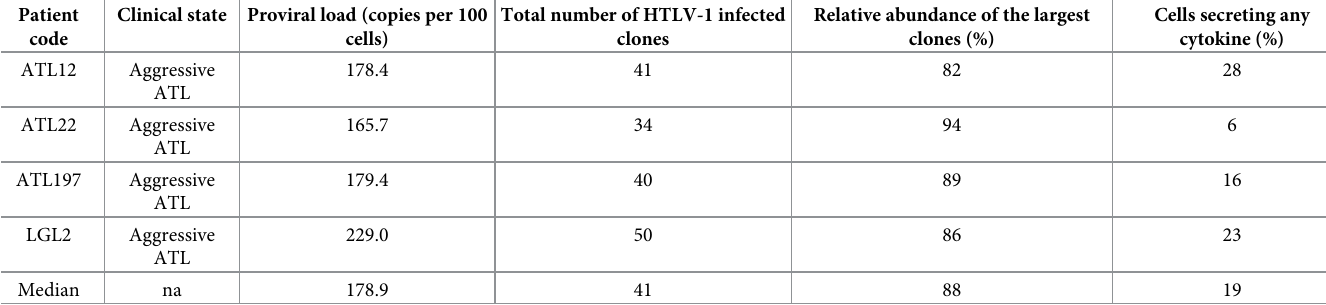
Table 2. Clonality and cytokine producing profile of CD4+CCR4+CD7- T cells in patients with ATL. Patient Clinical state Proviral load (copies per 100 code